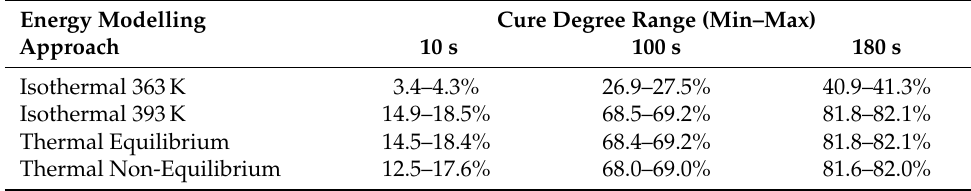
Table 6. Cure degree distribution ranges for each case during the curing